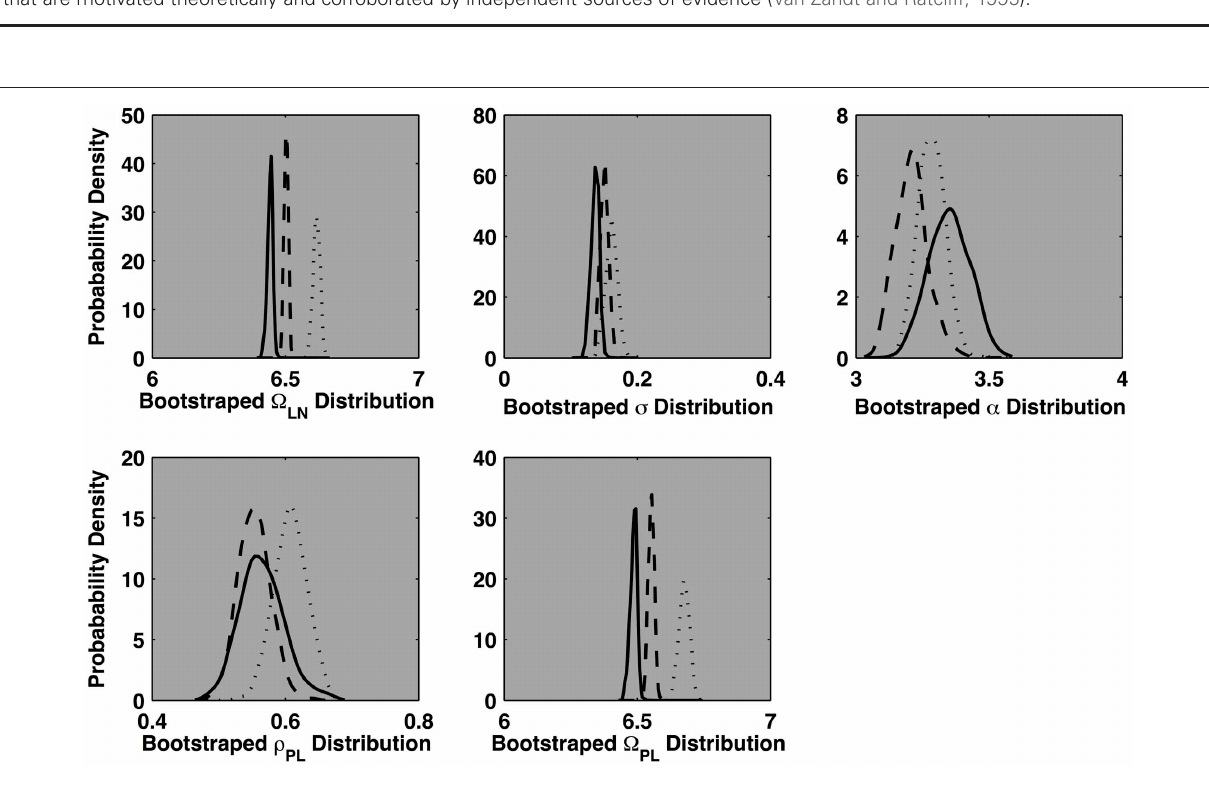
resampled data set and the resulting distribution of parameter values for each of the three mental rotation conditions are depicted in plots. Identical analyses of the mirror-reversed conditions indicated the 120 ◦ distribution as a rescaled version of the 0 ◦ and 60 ◦ distribution which, themselves were nearly